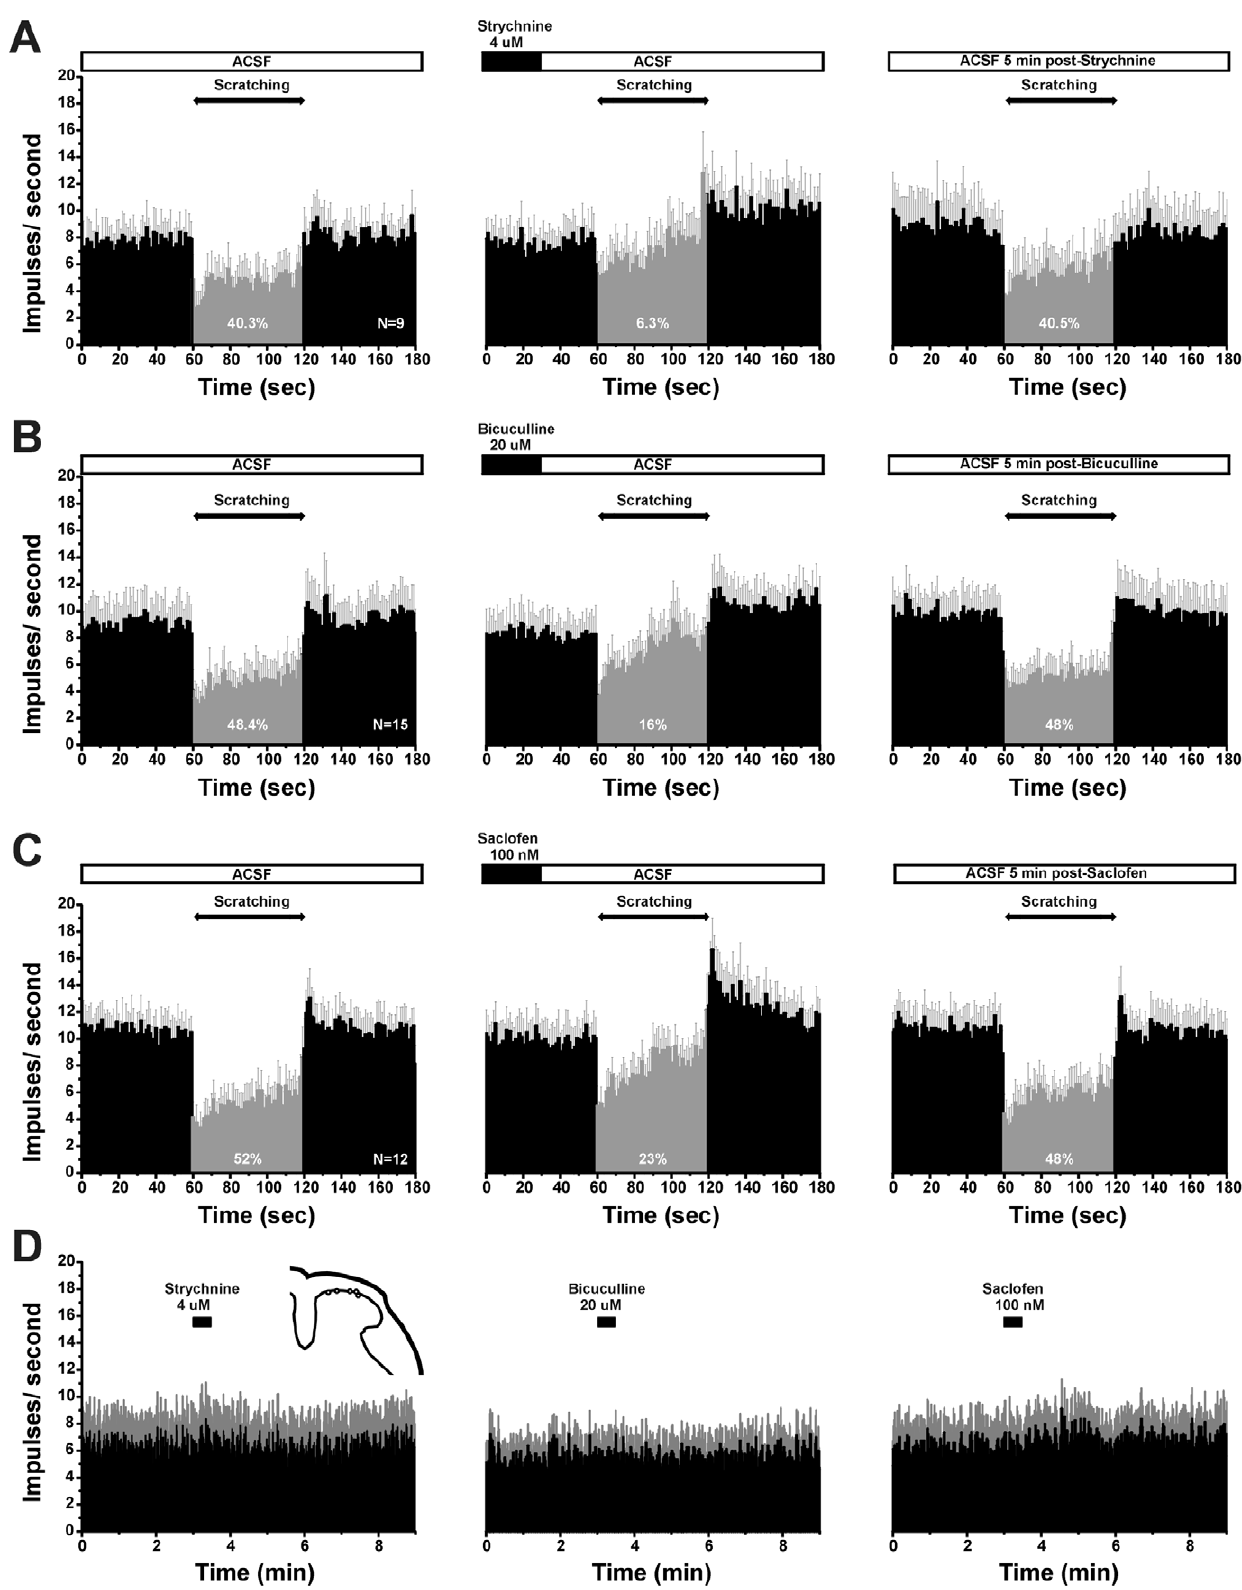
Figure 5. Glycine and GABA antagonists reduce scratch-evoked inhibition. A: PSTHs (bins: 1 sec) of averaged firing of 9 superficial dorsal horn units. Gray error bars: SEM. Left panel shows scratch-evoked depression of firing during ACSF superfusion. The gray portion of the PSTH highlights the scratch-evoked reduction in firing. Middle panel shows reduced inhibition following superfusion with glycine antagonist strychnine,